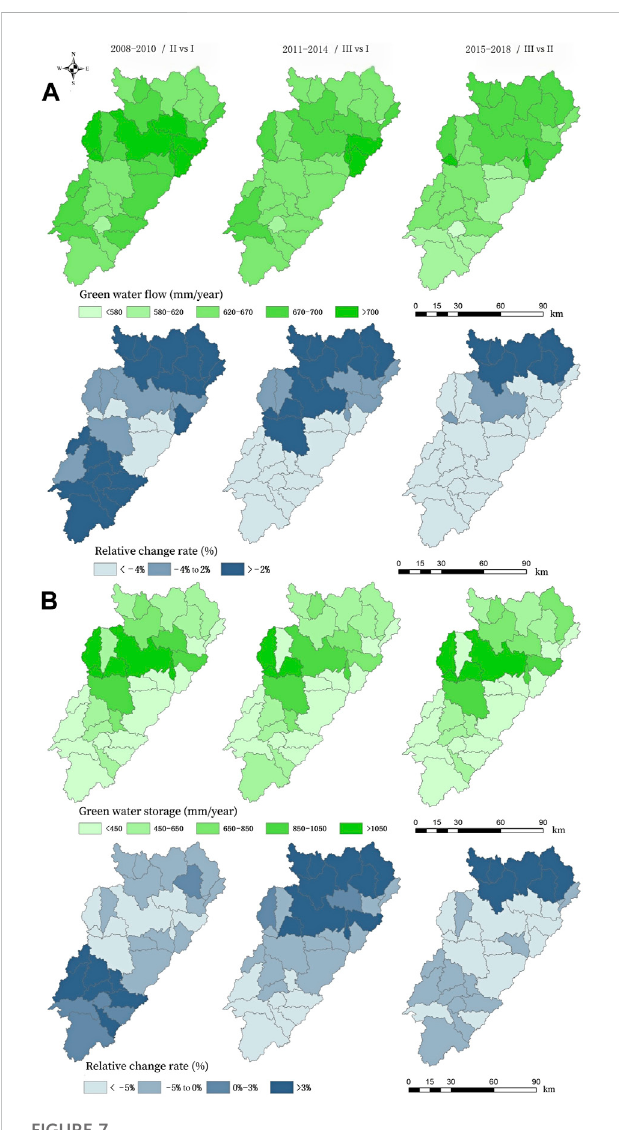
FIGURE 7 Spatial distribution of green water fl ow, green water storage and relative change rate in the Meijiang River Basin. (A) Green water fl ow and relative rates of change; (B) Green water storage and relative rates of